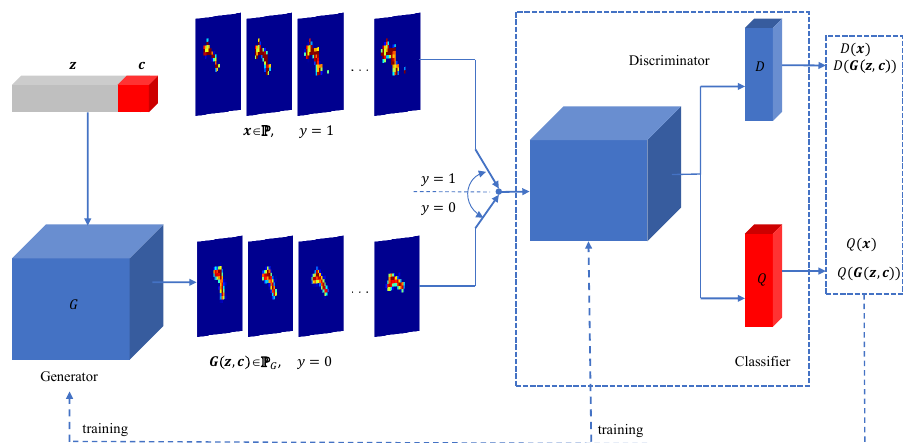
Figure 2. The architecture of GAN and InfoGAN. The basic GAN is obtained by excluding the red blocks and latent codes c